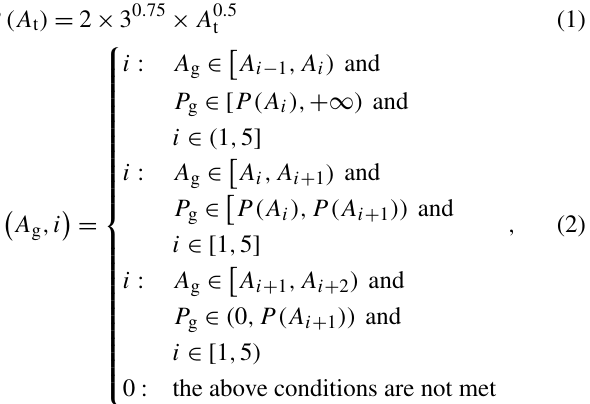
set according to the different levels (Table 1). P 4 , P 5 and P 9